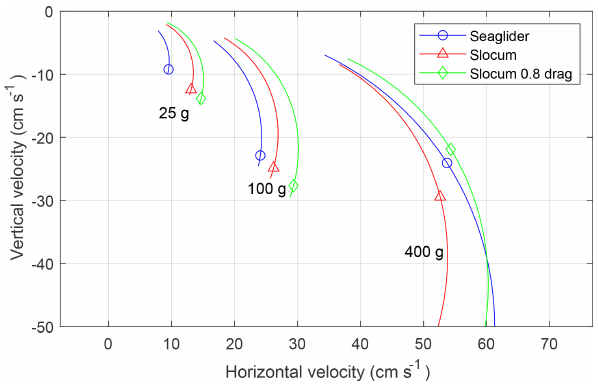
Figure 3. Performance as reflected in velocity (speed polars) of the Seaglider and the Slocum glider for three different net buoyancies of 25, 100 and 400g. Also shown: a hypothetical Slocum glider with half volume and 20% reduced drag. At low vertical speeds, the polars are cut off at an angle of attack of 5 ◦ . The angle of attack decreases with increasing vertical